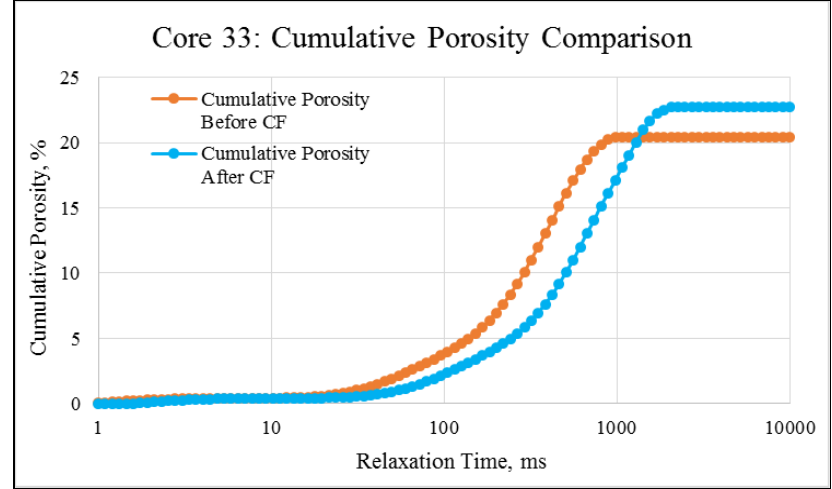
Figure 9. NMR cumulative porosity comparison of C#33: before and after the coreflood.